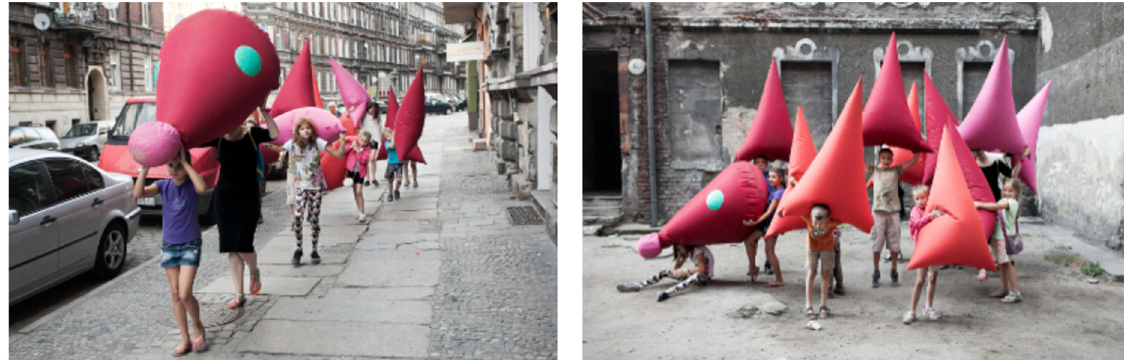
Figure 5 . Lza Rutkowska Pri’s work “Hedgehog” in “Everyone’s Backyard” project. Reprinted with permission from [77]. Copyright 2015, Lza Rutkowska Pri.